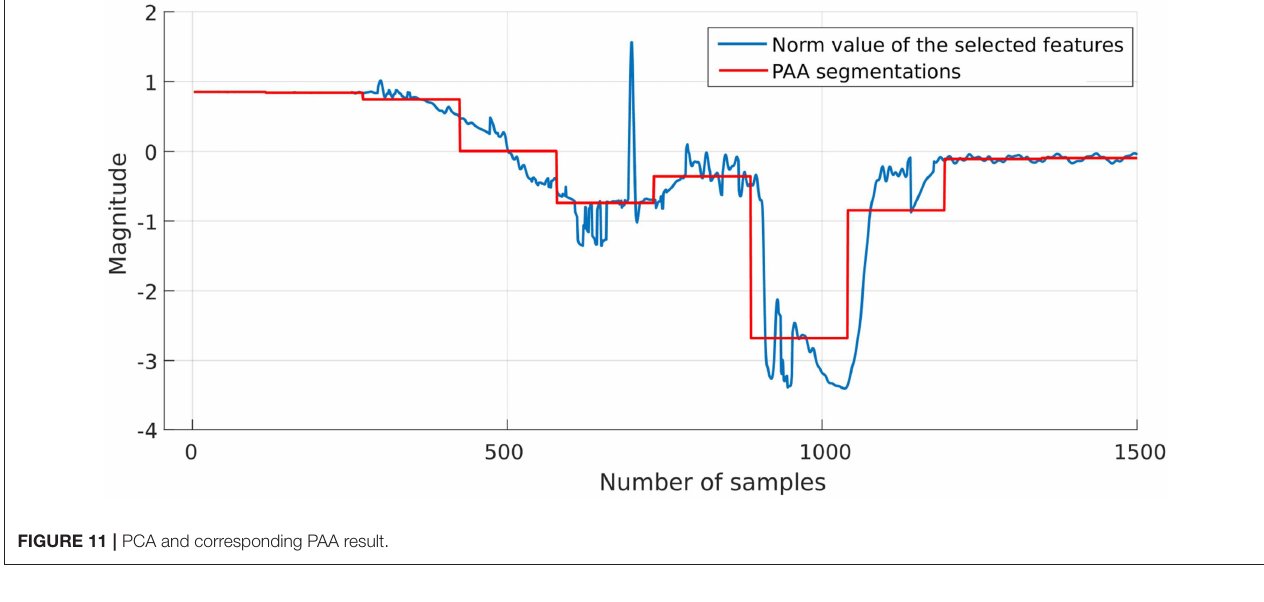
FIGURE 11 | PCA and corresponding PAA result.